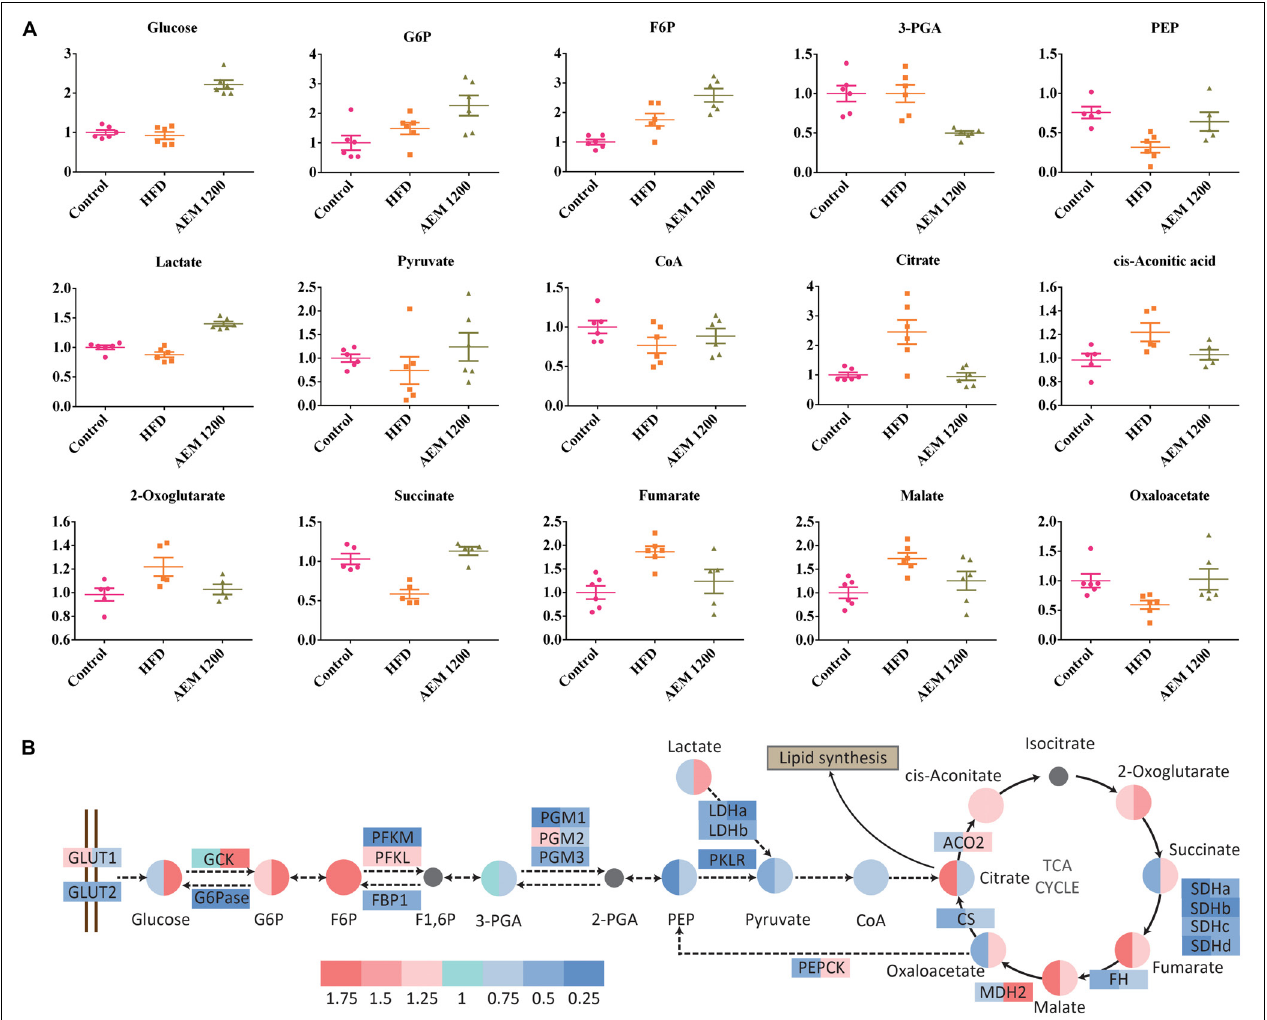
FIGURE 5 | Aqueous extract of black maca (AEM) influences the metabolism of the glycolysis/gluconeogenesis pathway and the TCA cycle. (A) The scatter plot of the relative quantities of the energy metabolites in liver samples from the treated and untreated groups. The Y -axis data were normalized according to the average value of the control. (B) Differential analysis of the glycolysis/gluconeogenesis pathway and the tricarboxylic acid (TCA) cycle among the control group (Con), the HFD model group (HFD), and the 1,200 mg/kg AEM group (AEM 1200). Log 2 fold changes of metabolites and the ratios of the average values of gene expression are color-coded, n =